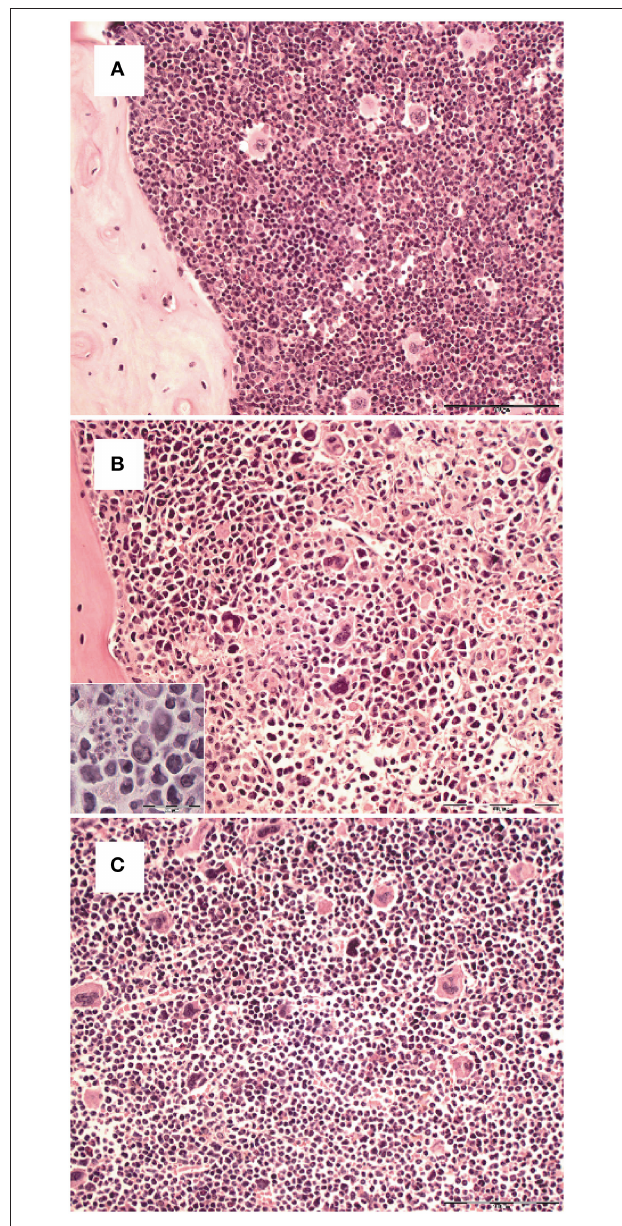
FIGURE 5 | Transient loss of bone marrow stroma integrity during the course T. cruzi infection. C57BL/6 mice were infected with 75 T. cruzi blood trypomastigotes i.p.. (A) Histopathological analysis of H&E stained sections of formalin-fixed and paraffin-embedded bones from hind legs of uninfected (A) and infected mice ( B : 14 dpi; C : 35 dpi). Representative micrographs of one out of 5 mice are shown. (Bar, 100 µ m. Inset, intracellular parasites in stromal cells; bar, 50 µ